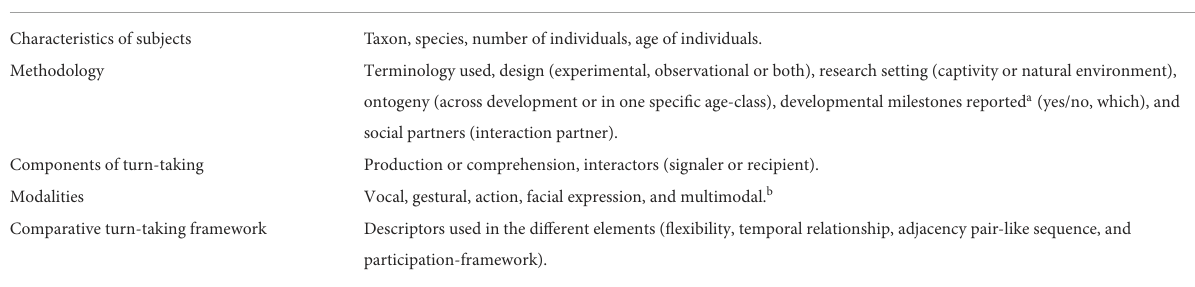
TABLE 1 Information extracted from the